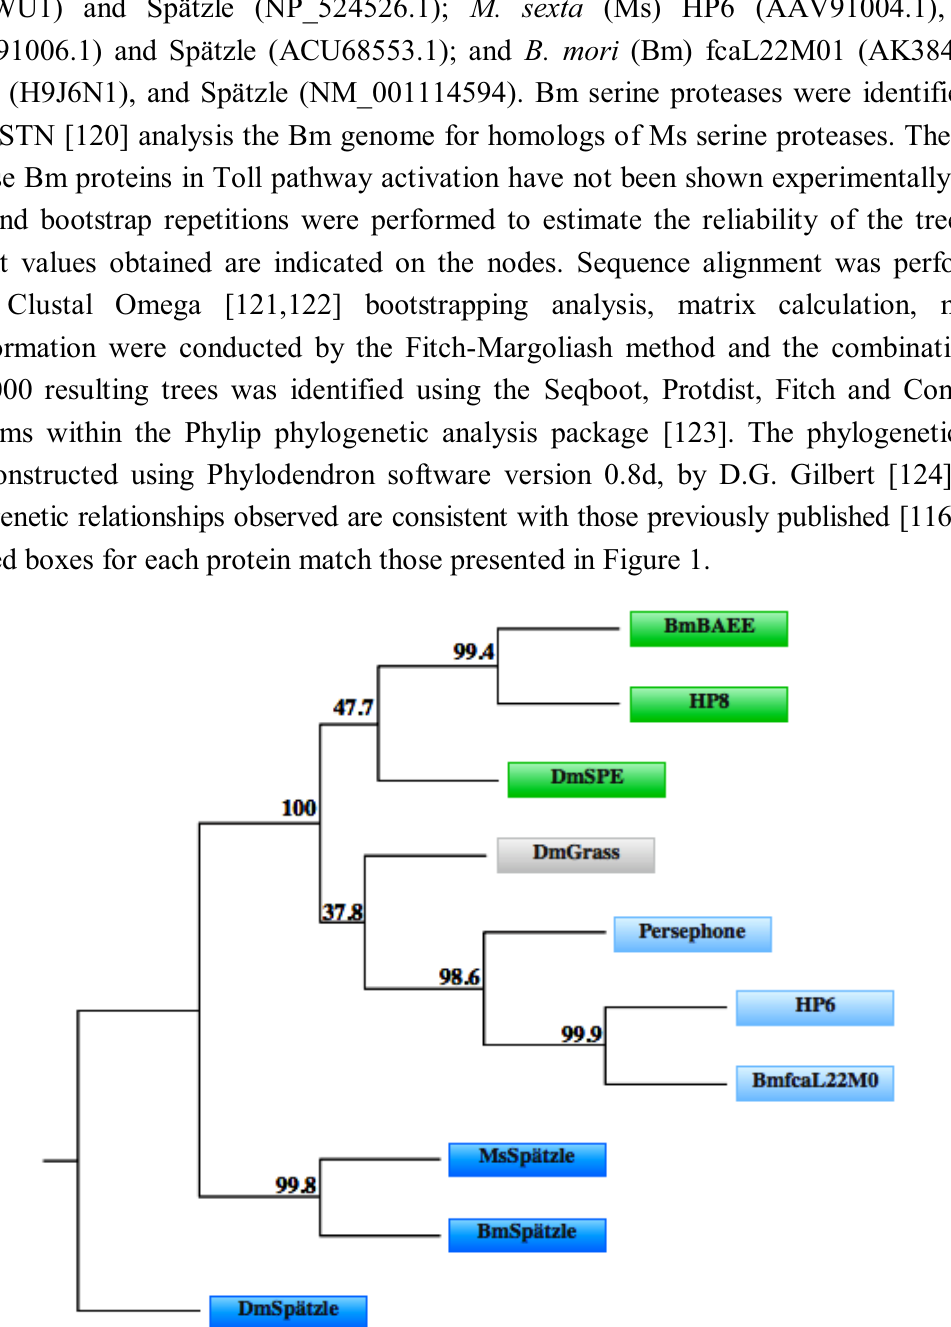
Figure 2. Phylogenetic relationships among serine proteases involved in Toll pathway activation. Sequence alignment and tree construction were performed using the amino acid sequence of D. melanogaster (Dm) Grass (Q86PB3), SPE (NP_651168.1), Persephone (Q9VWU1) and Spätzle (NP_524526.1); M. sexta (Ms) HP6 (AAV91004.1), HP8 (AAV91006.1) and Spätzle (ACU68553.1); and B. mori (Bm) fcaL22M01